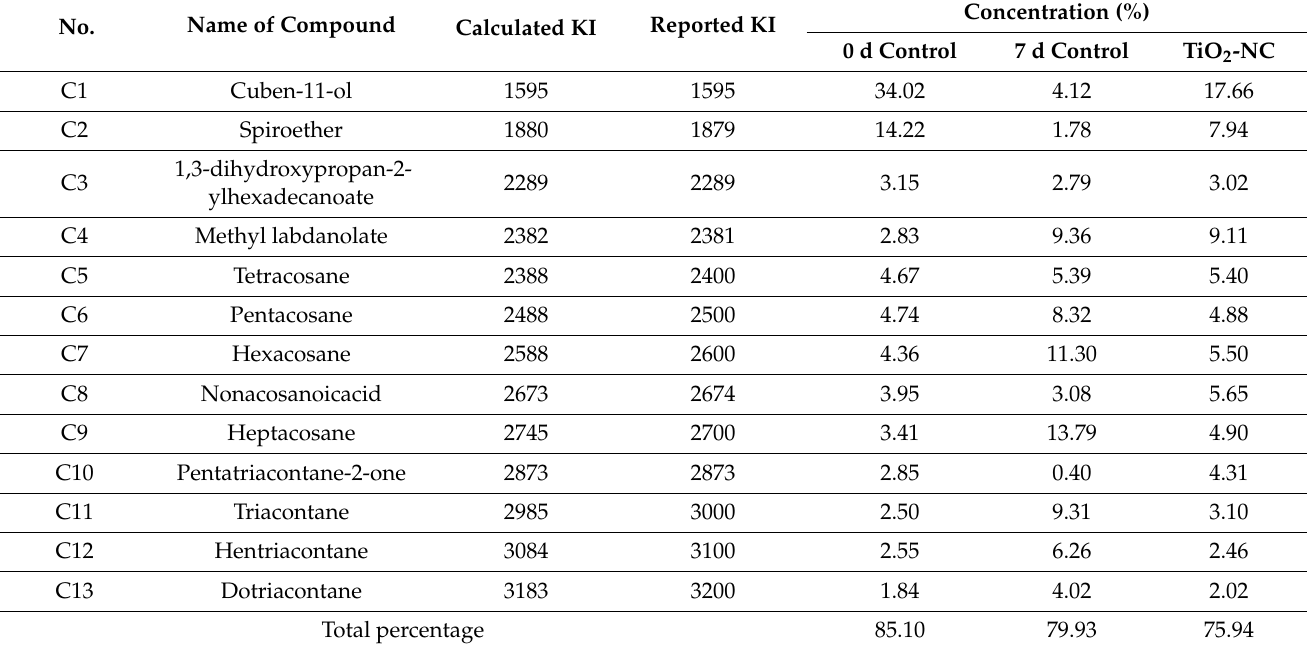
Table 1. Major composition of essential oil in C. annuum fruit under various